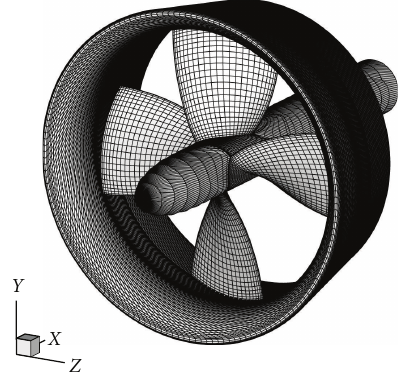
Figure 4: Panel arrangement for propeller Ka4-70 inside duct 19Am. 50 × 25 panels on each blade; 142 × 160 panels on the duct; 55 × 80 panels on the